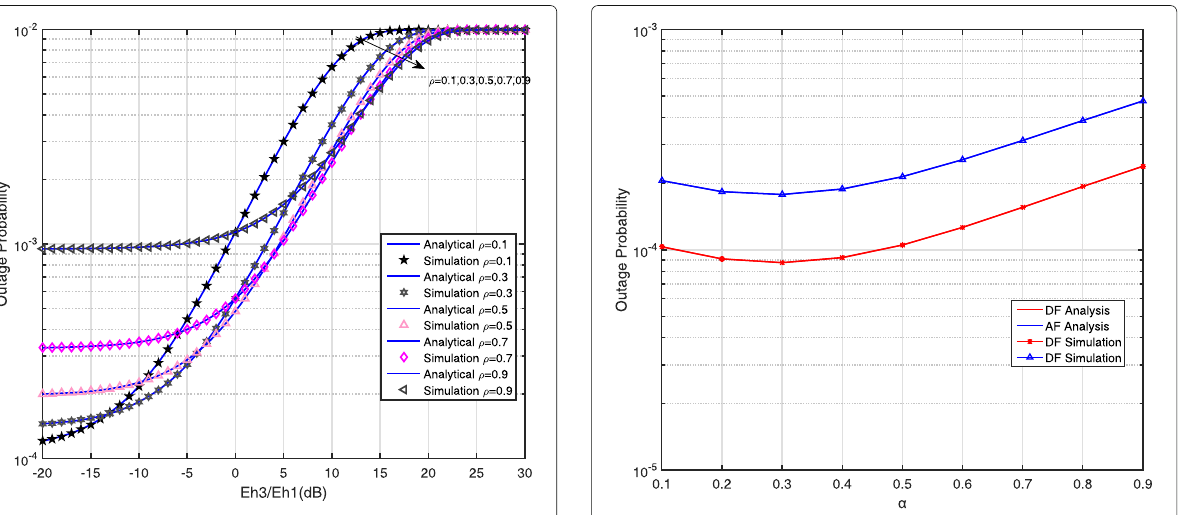
which leads to a higher capacity, but with the increment of E h 3 / E h 1 , the relay link channel will be worse, so the out- age probability will become greater when the ρ increases at the same value of E h 3 / E h 1 . In Fig. 3, the outage probabil- ity curves under AF schemes are presented where E h 1 = E h 2 = 1 and ρ = { 0.1, 0.3, 0.5, 0.7, 0.9 } . We can get that